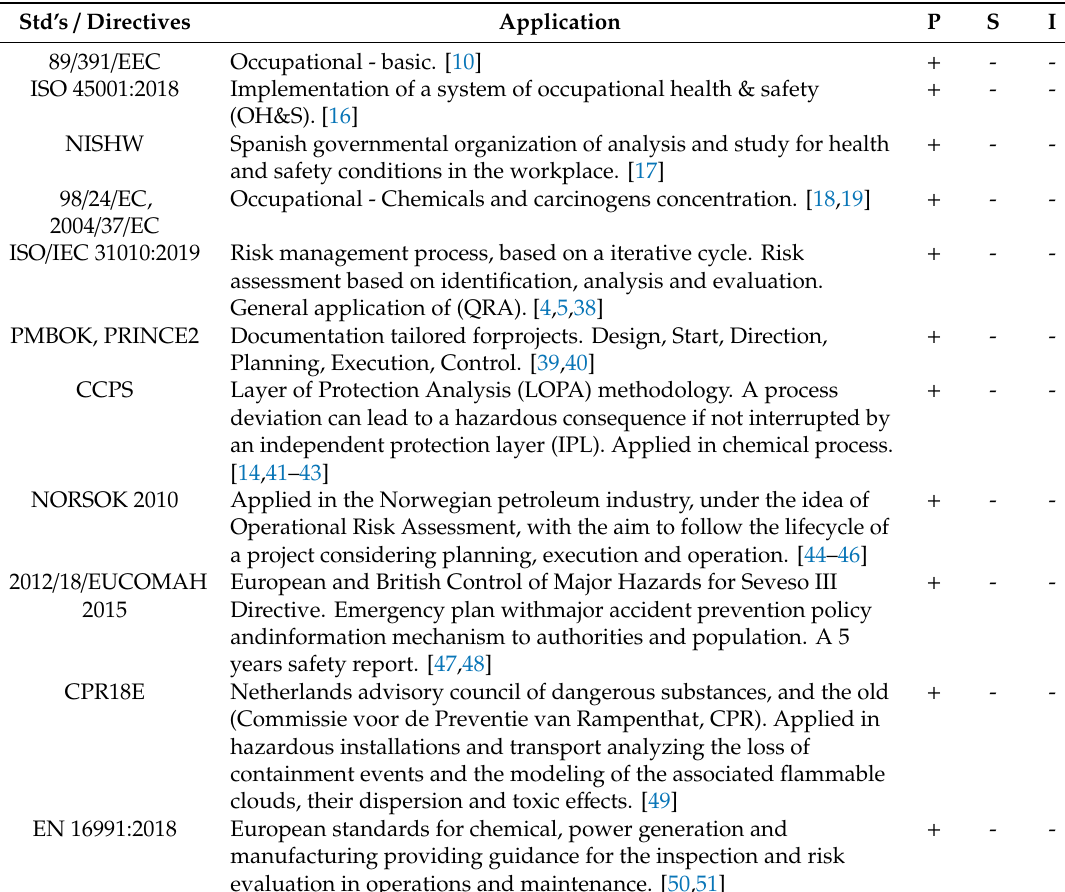
Table 1. Existing standards and